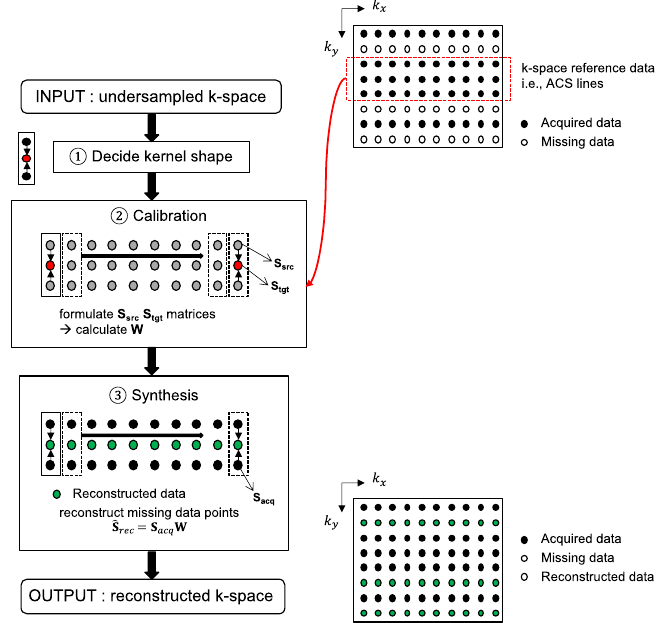
Figure 1. A flow chart of the 2D-GRAPPA reconstruction algorithm. To aid with explanation, k x - k y plane is displayed as an input. After determining the form of the kernel (e.g., estimating a missing data point using two adjacent obtained points along the k y direction), calibration is performed on the k-space reference lines. The precalculated weighting values are then subsequently used for reconstruction of non-ACS line regions.